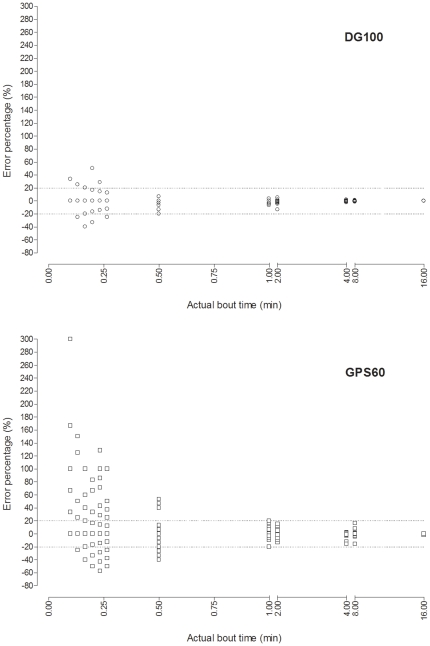
Graphical representation for both the DG100 and the GPS60, of the error percentage for time difference between actual and detected bouts according to actual bout time.Note: concentrations of point near 0% for the DG100 give the impression that there were fewer points, particularly for bouts less than 0.5 min. This was not the case. For instance, there were 65 and 70 bouts of 0.17 min (10 s) for the GPS60 and the DG100, respectivel.